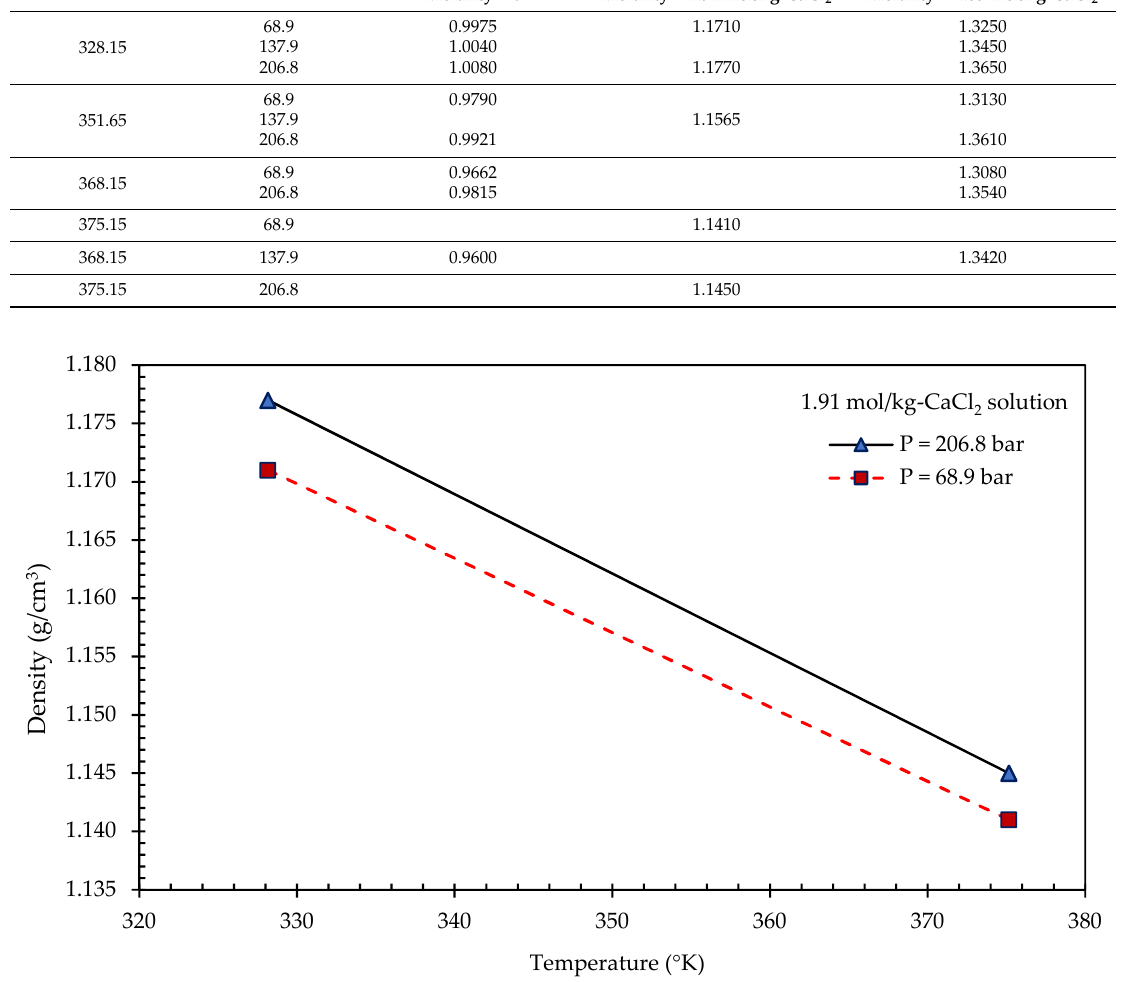
Figure 5. Experimental measurements of the density of a 1.91 mol/kg CaCl 2 solution saturated with CO 2 at 68.9 and 206.8 Bar versus temperature.